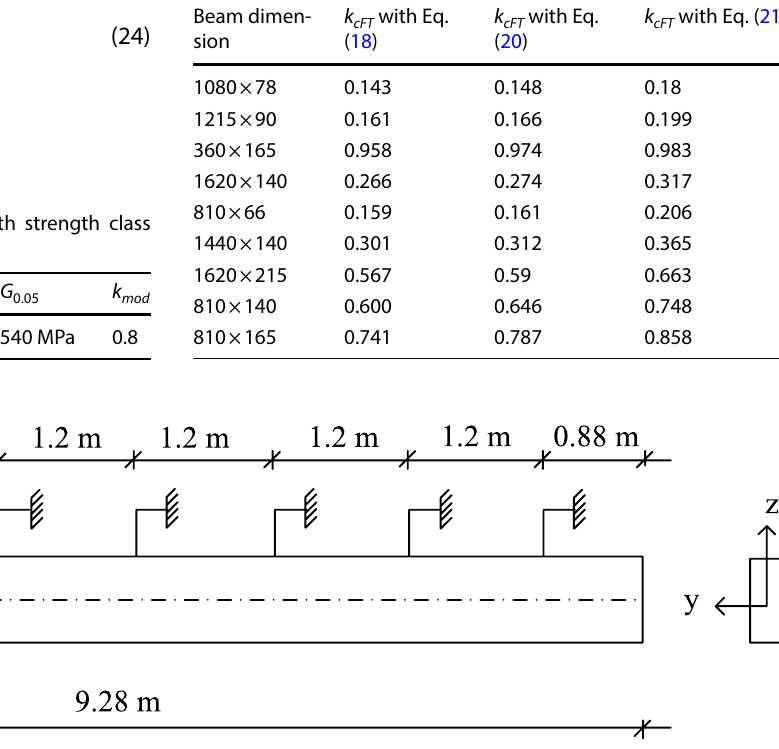
Fig. 2 Discrete bracing of the roof beam at the upper level of the beam (compressive edge) with lateral supports